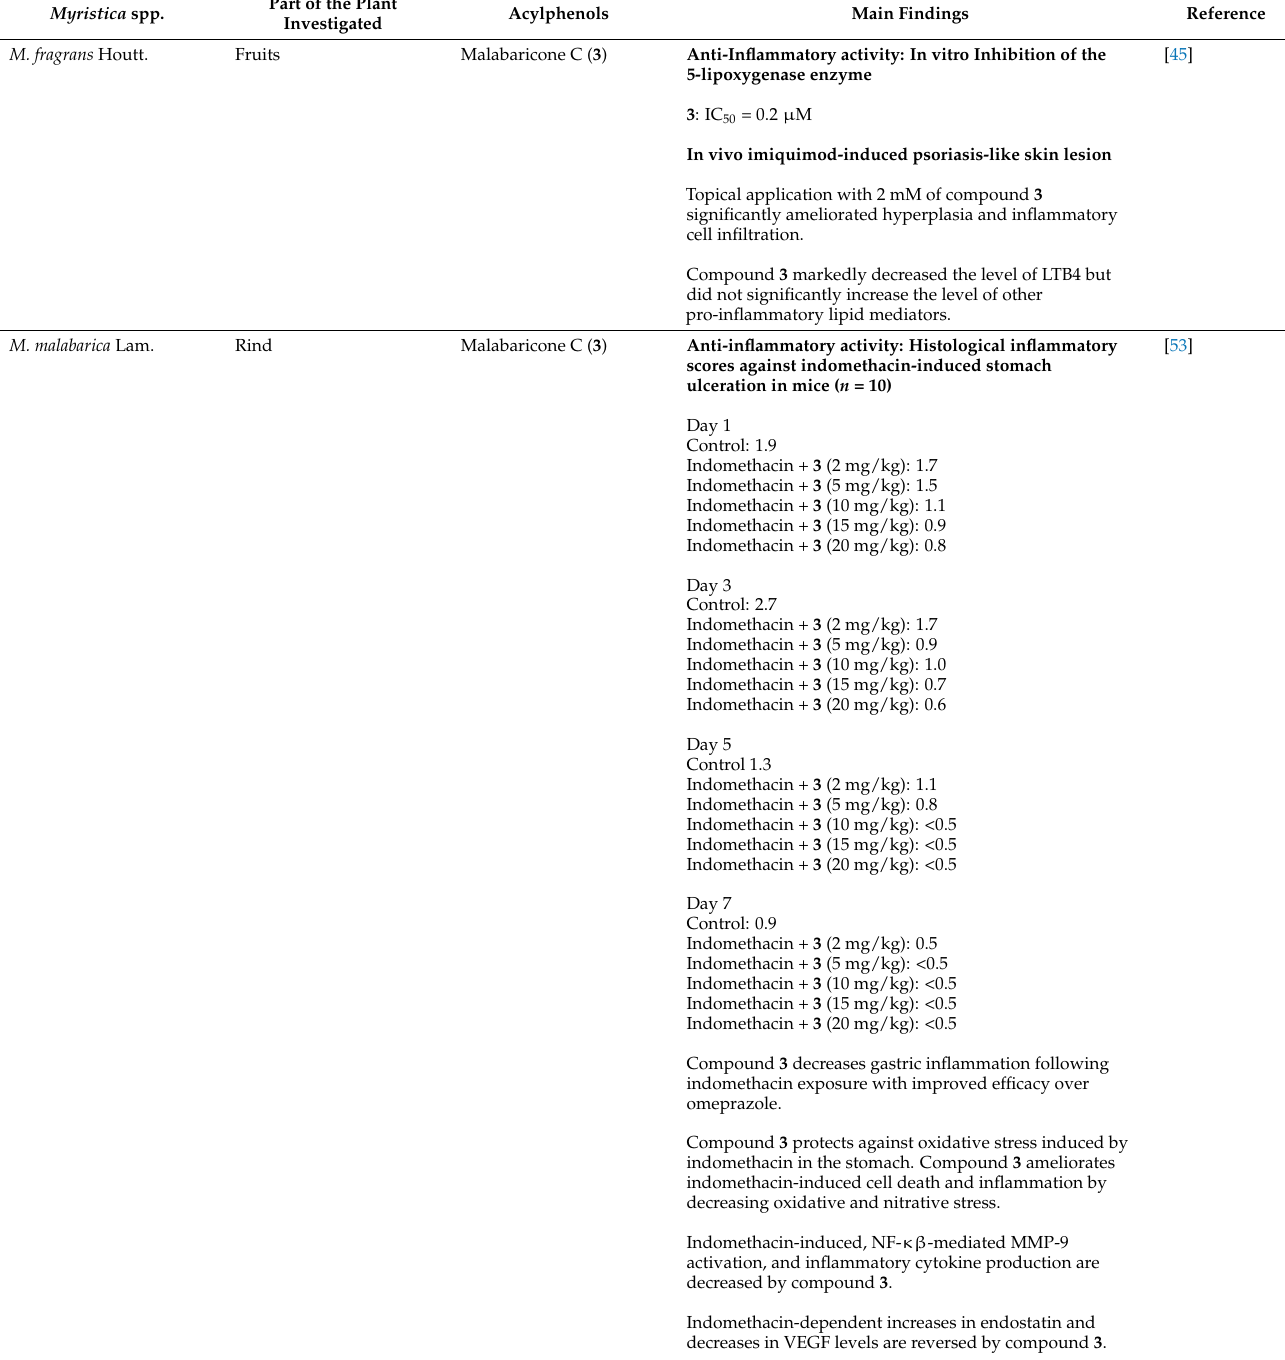
Table 4. The anti-inflammatory activities of acylphenols from the genus Myristica